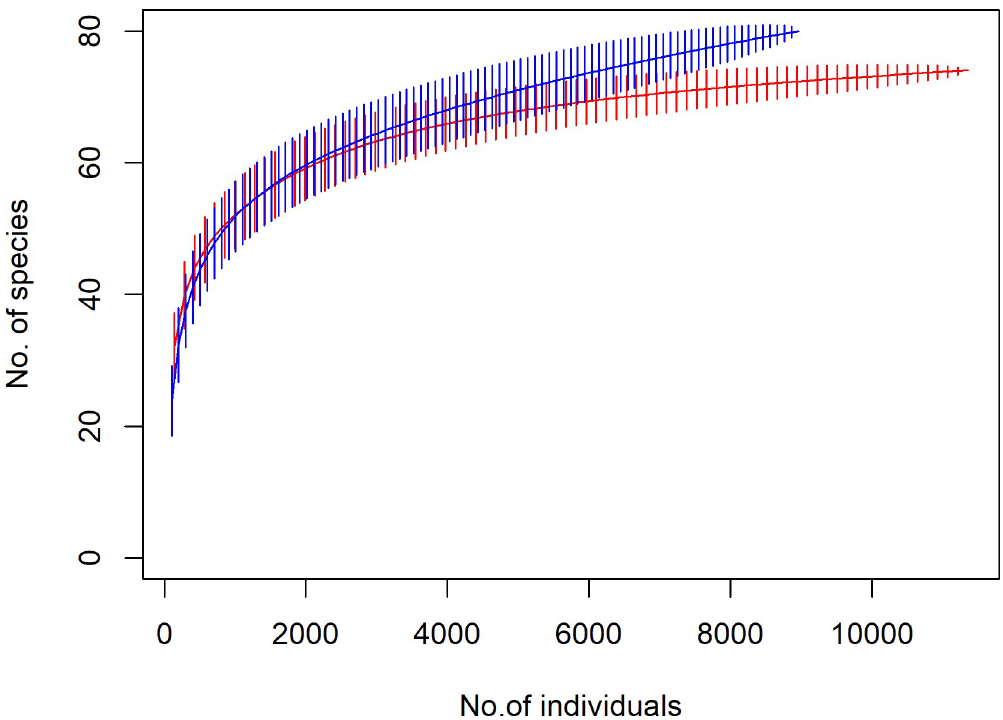
Fig 2. Comparative richness in fish species of Madhya Pradesh and West Bengal. Species accumulation curve (method = rarefaction) showing differences in total number of species per individuals sampled for MP (in red) and WB (in blue).